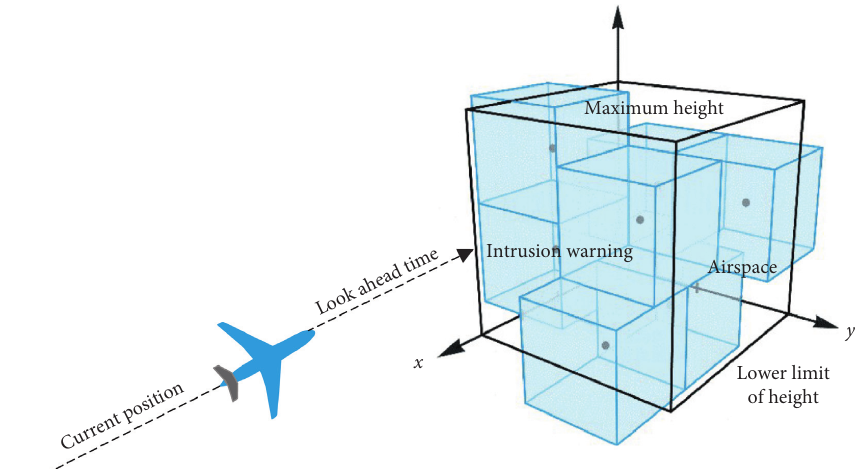
Figure 7: Schematic diagram of airspace intrusion warning